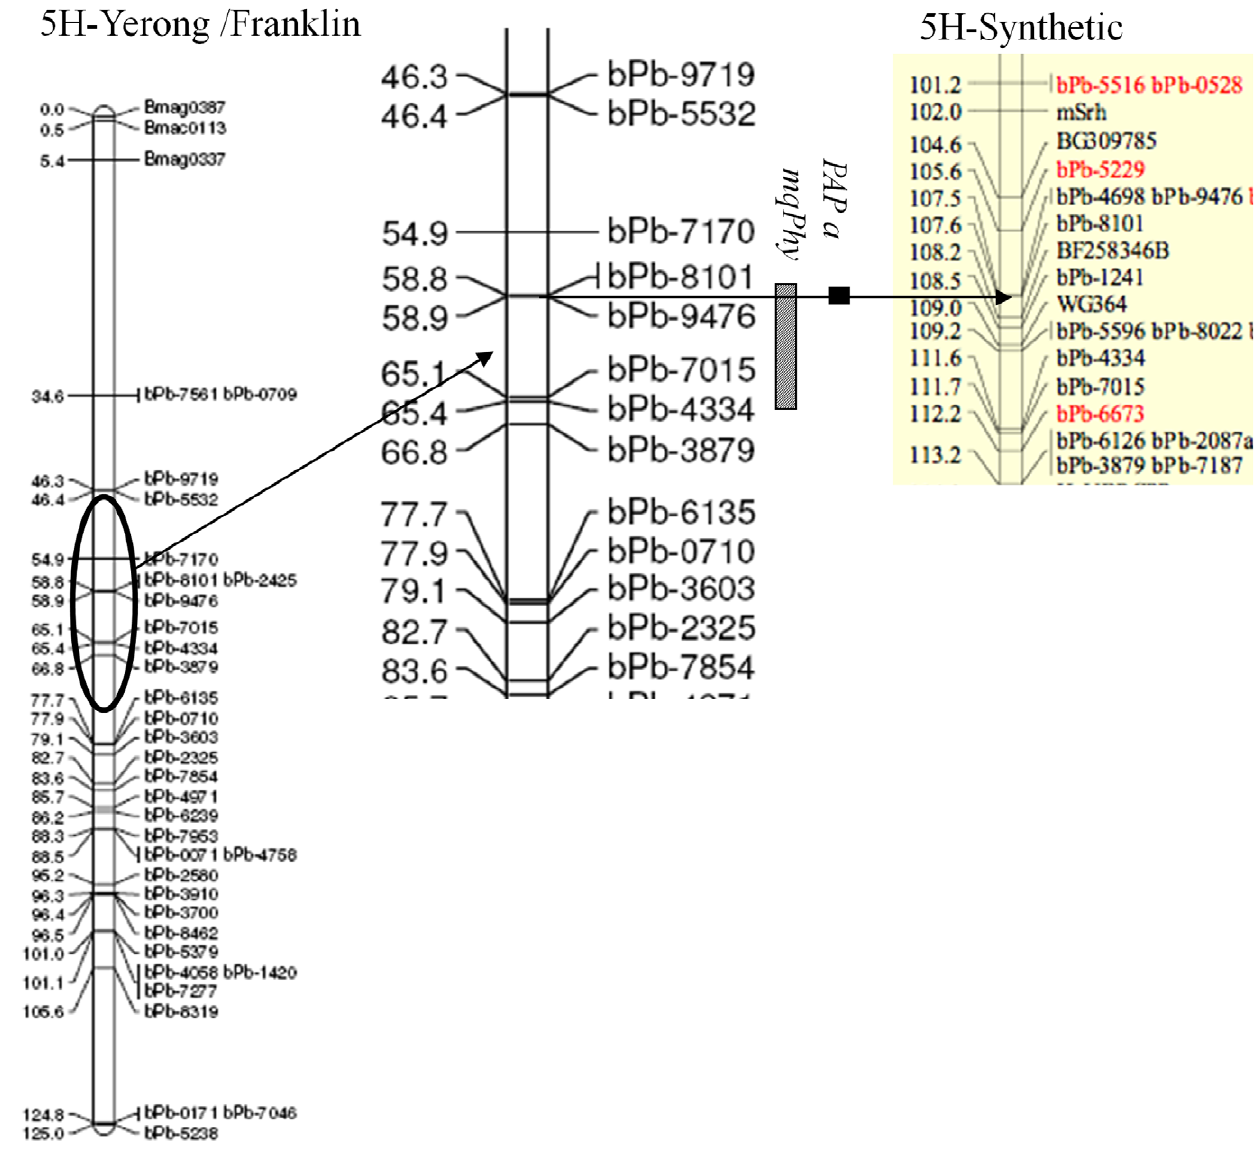
Figure 5. Quantitative trait loci (QTLs) identified for plant phytase activity in the DH population of Yerong/Franklin. This figure is for chromosome 5 H (Li et al., 2008). Part of synthetic map (Alsop et al., 2011) was added to the right for comparison. Arrows point out the position of closest DArT markers for mqPhy and HvPAP a genes in two different maps.